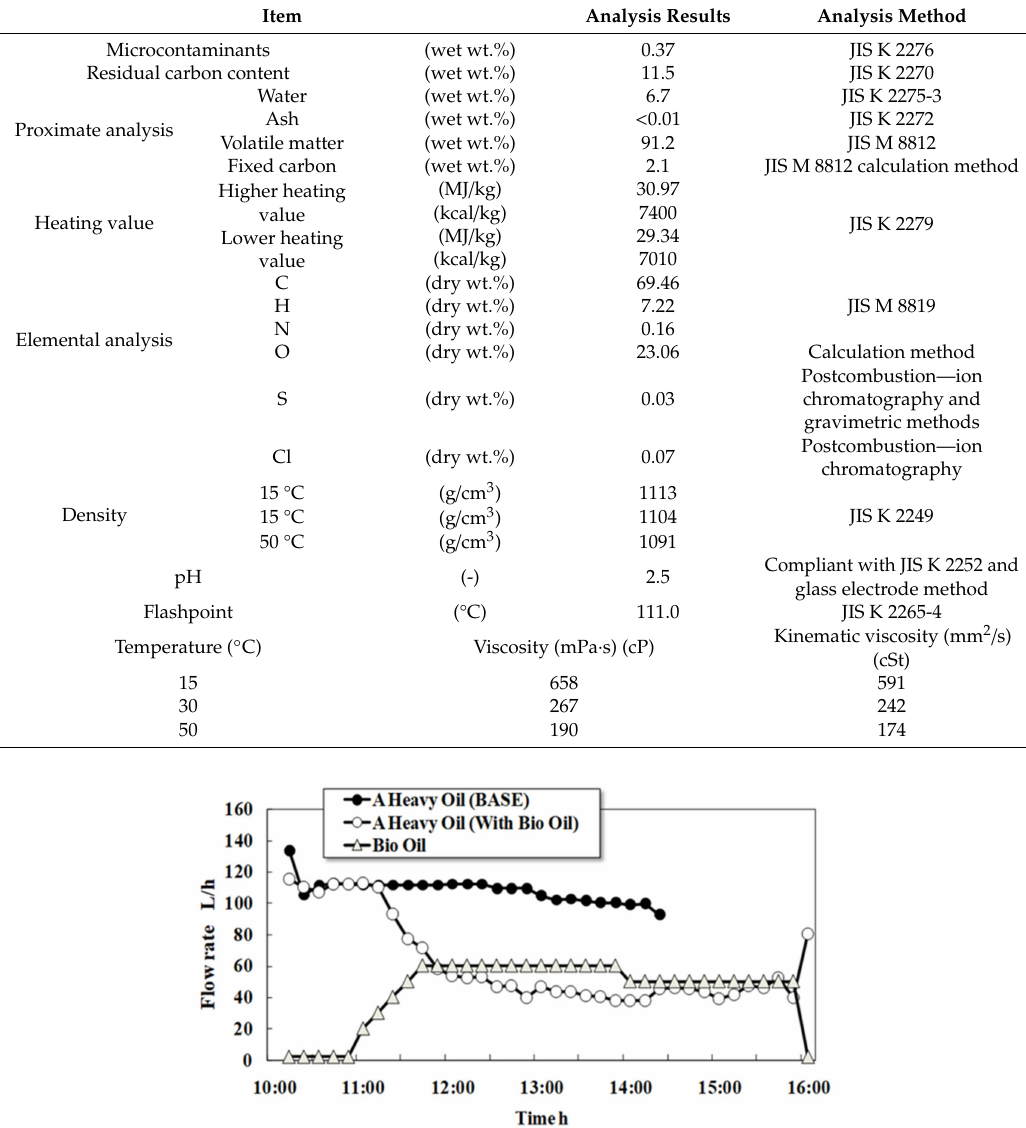
Table 1. Properties of bio-oil.